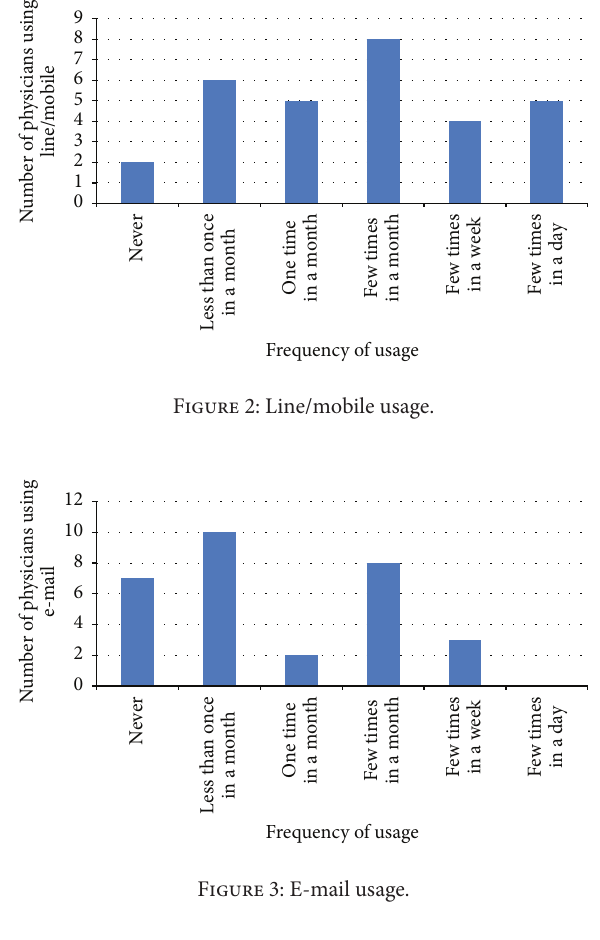
Figure 3: E-mail